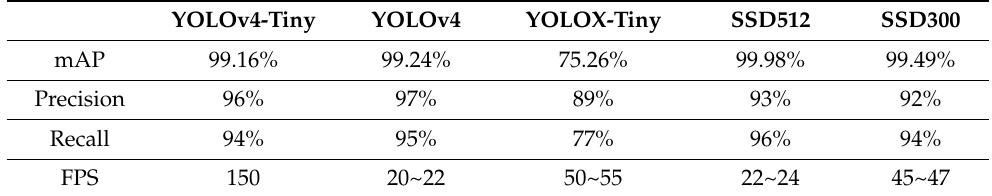
Table 19. Comparisons of the side-view training results among different neural